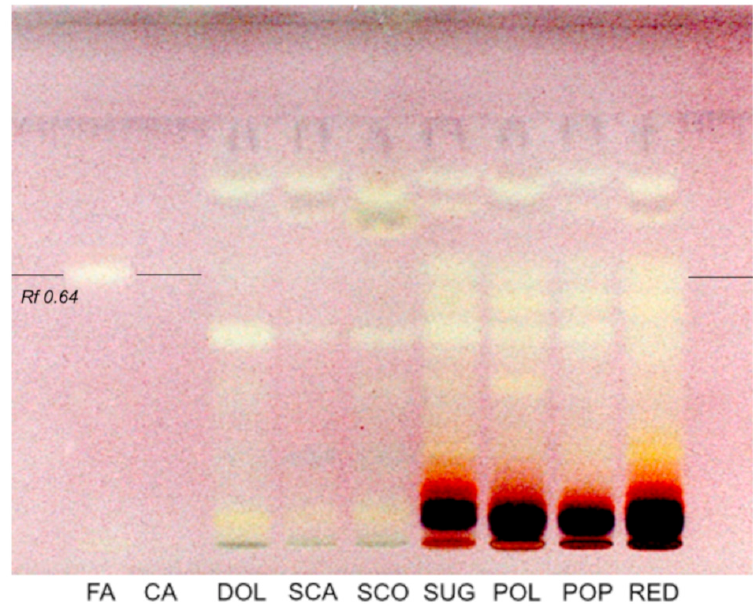
Figure 4. HPTLC patterns of soluble phenolic fractions at visible light after derivatization with DPPH solution. Standard phenolic acids were run in parallel (FA: ferulic acid, CA: coumaric acid, DOL: Dolce, SCA: Scagliolo, SCO: Scoppio, SUG: Sugary, POL: Polenta, POP: Pop, RED: Reduno).